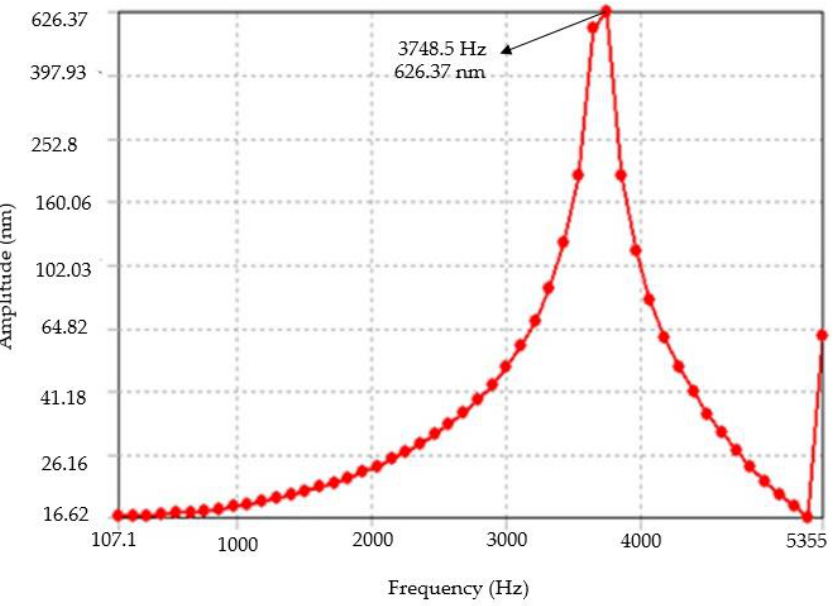
Figure 7. Harmonic response of the bearing